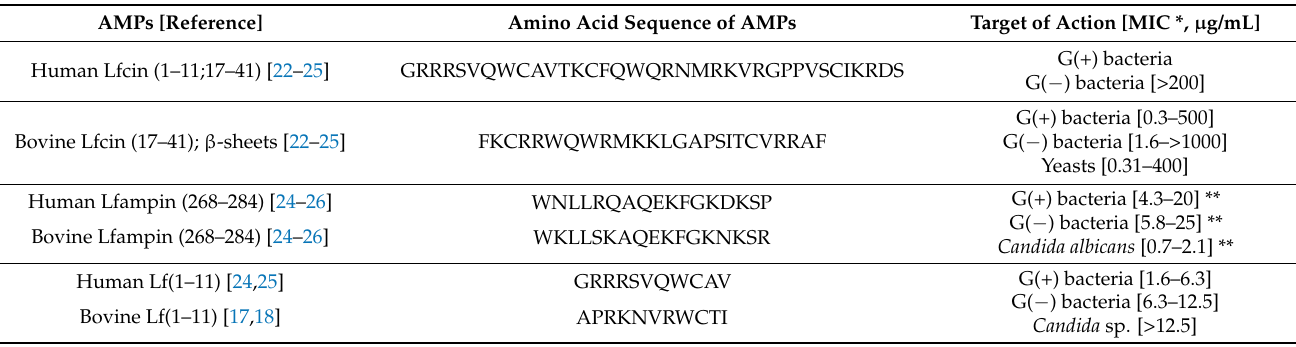
Table 1. Characteristics of lactoferrin-derived